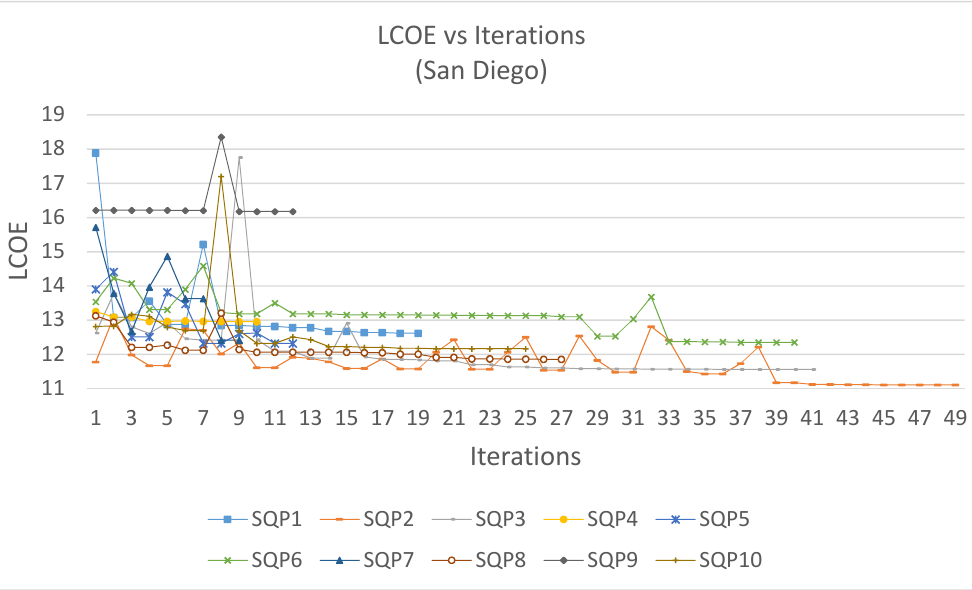
Figure 3. Optimization iteration summary for San Diego. 393